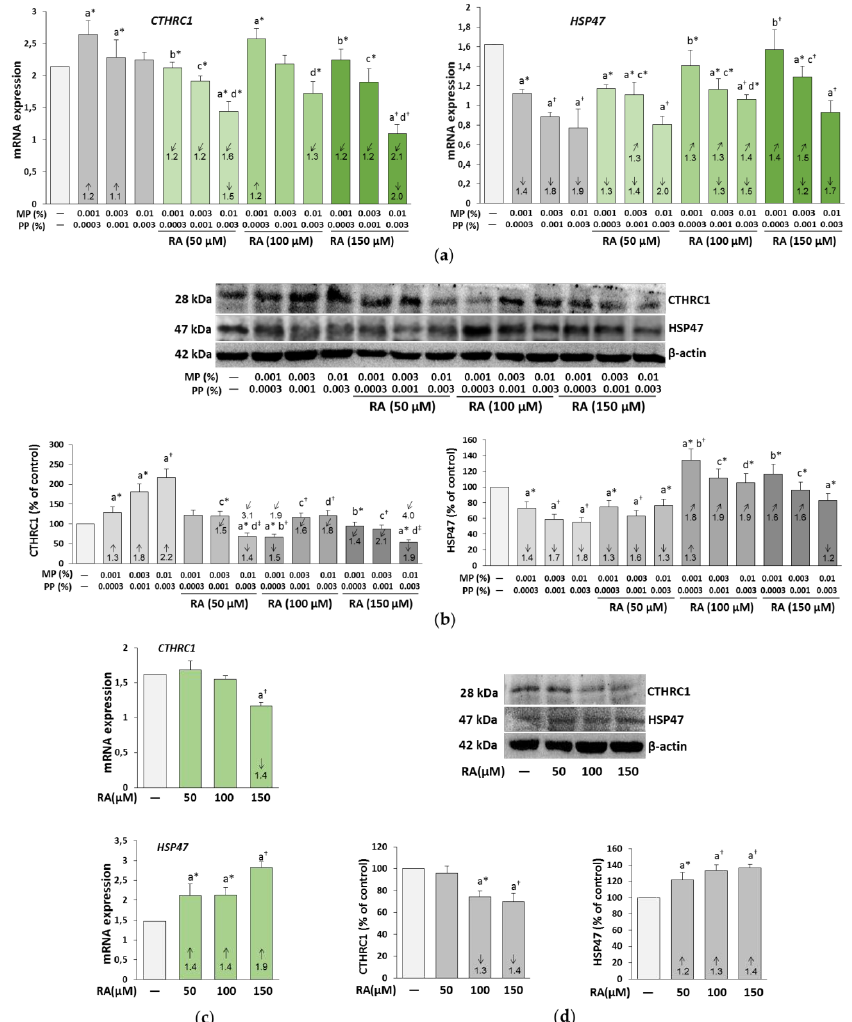
Figure 6. The influence of rosmarinic acid (RA) on the expression of Collagen Triple Helix Repeat Containing-1 (CTHRC1) and Heat shock protein, 47 kDa (HSP47) at mRNA ( a , c ); and the protein ( b , d ) levels in the fibroblasts treated with methylparaben (MP) and n-propylparaben (PP) ( a , b ), and untreated cells ( c , d ). Expression of genes was assayed by real-time PCR, values represent the mean ± SD of three experiments done in duplicate ( a , c ). Representative gels of Western blotting, the intensity of the bands was quantified by densitometry and normalized to β-actin, values represent the mean (% of control) ± SD of three experiments ( b , d ). Statistically significant differences are marked as: a vs. control, b vs. 0.001% MP and 0.0003% PP, c vs. 0.003% MP and 0.001% PP, d vs. 0.01% MP and 0.003% PP; * p < 0.05; † p < 0.01; ‡ p < 0.001. The values in the bars show a factor of change in comparison to the control ( , increase; , decrease) or to the respective samples treated with parabens alone (MP and PP) ( ↗ , increase; ↙ , decrease).